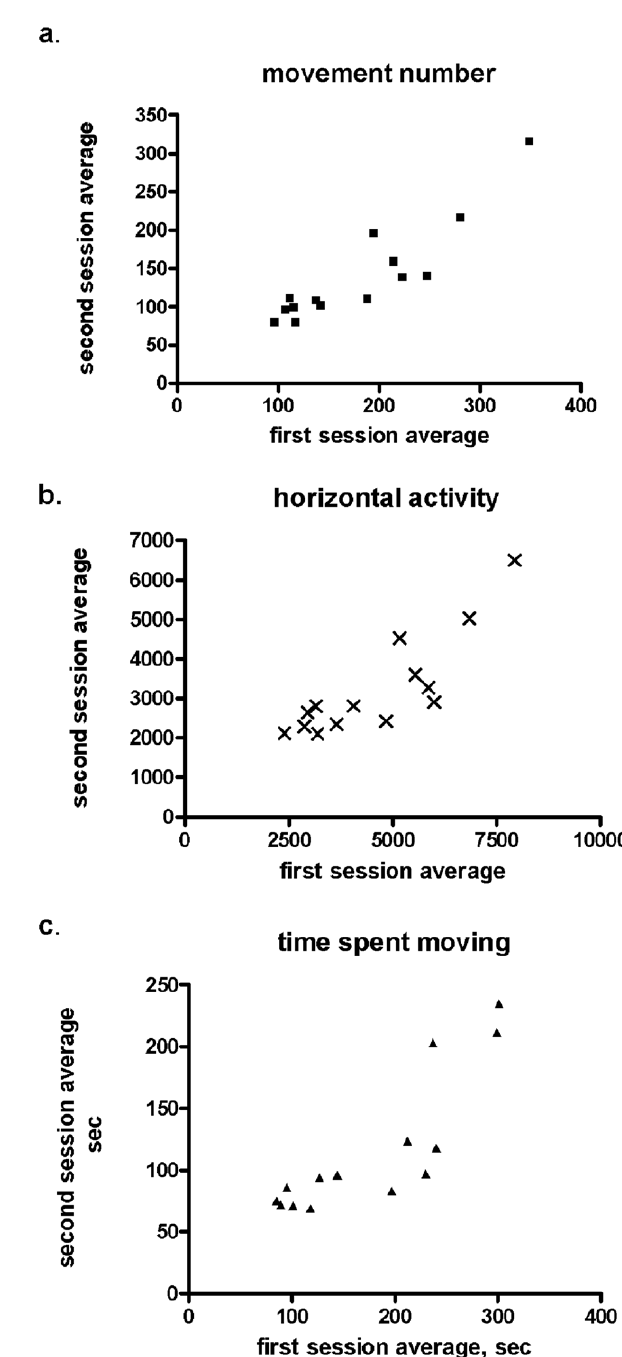
Figure 5. Individual locomotor activities with respect to group throughout the life span. Young adult and old rats were tested at 4 and 22 months old, and again at 12 and 30 months old. There was a significant correlation in locomotor activity between the mean performance for each test subject at the first testing period (ten trial average) and second testing period (seven trial average) of locomotor activity tested eight months later: a. movement number, p , 0.0001, r=0.865; b. horizontal activity (HAC), p =0.0001, r=0.846; c. time spent moving (as seconds per hour), p , 0.0001, r=0.868. Data not shown are movement speed (cm/sec), p =0.0001, r=0.848, and distance traveled (cm/hr), p , 0.0001, r=0.881.